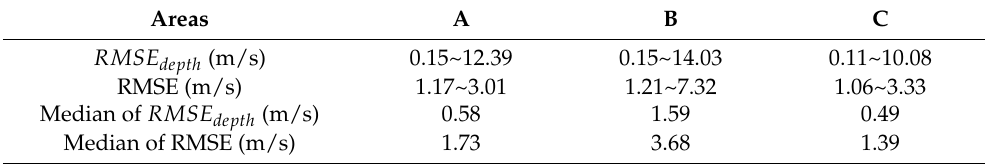
Table 3. The RMSE and 𝑅𝑀𝑆𝐸 (cid:3031)(cid:3032)(cid:3043)(cid:3047)(cid:3035) in Areas A, B, and C. Table 3. The RMSE and RMSE depth in Areas A, B, and C. Areas Areas A B C RMSE depth (m/s)